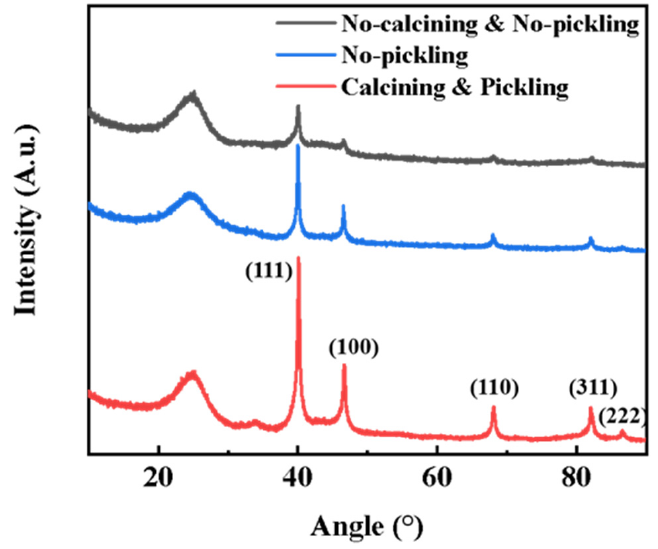
Figure 1. The XRD of Pd/C catalysts under different synthesis conditions.